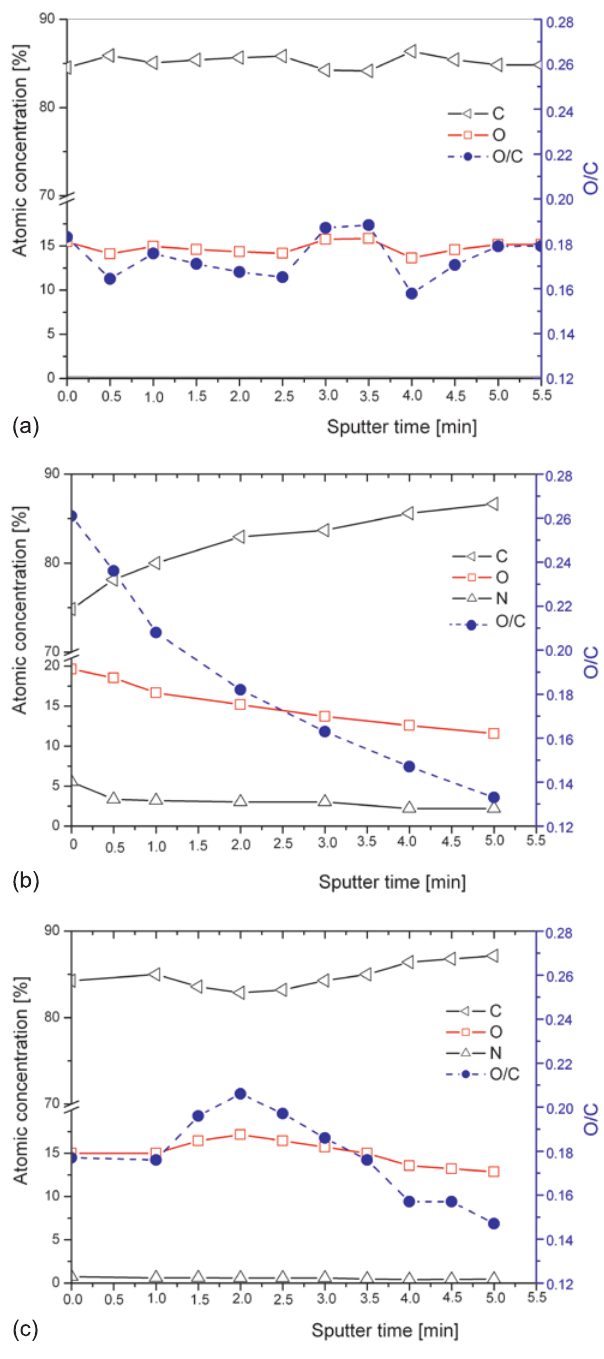
Fig. 5: XPS depth profiles of carbon, oxygen and nitrogen concentrations and O/C ratio after sputtering process by Ar + ions of virgin PEEK (a), PEEK treated in He+N 2 (b), and PEEK treated in N 2 O